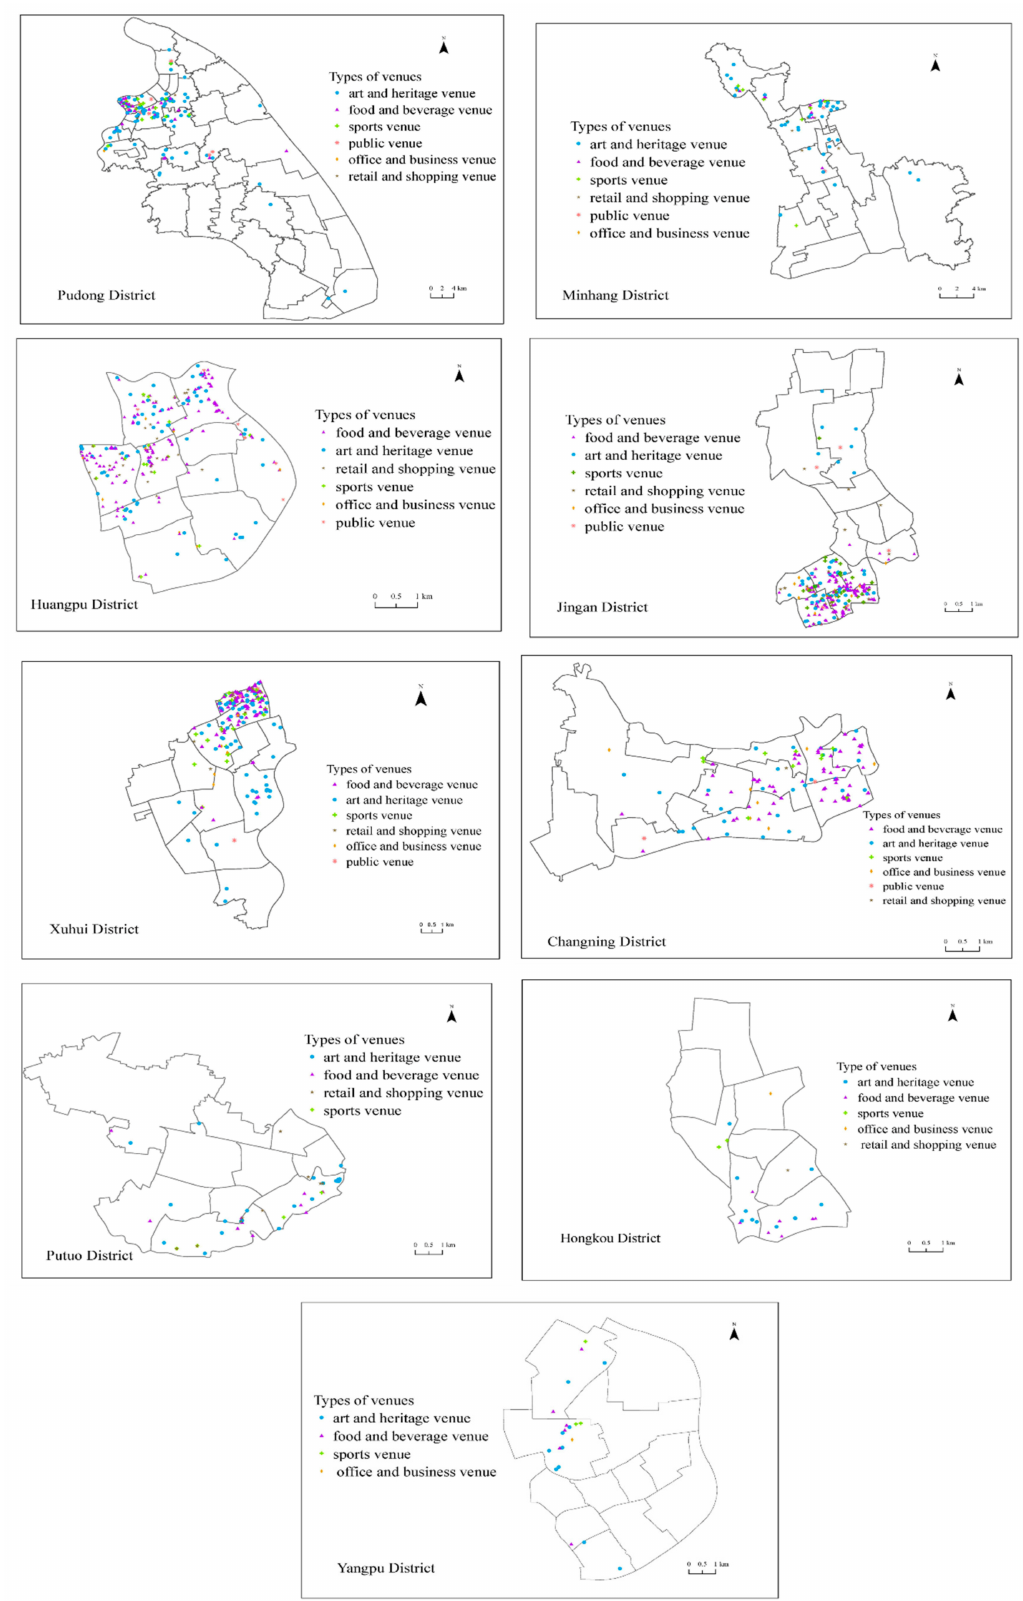
Figure 9. Location of venue sectors at the level of districts. Note: The figures for Songjiang, Qingpu, and Baoshan districts are missing due to the limited number of cultural